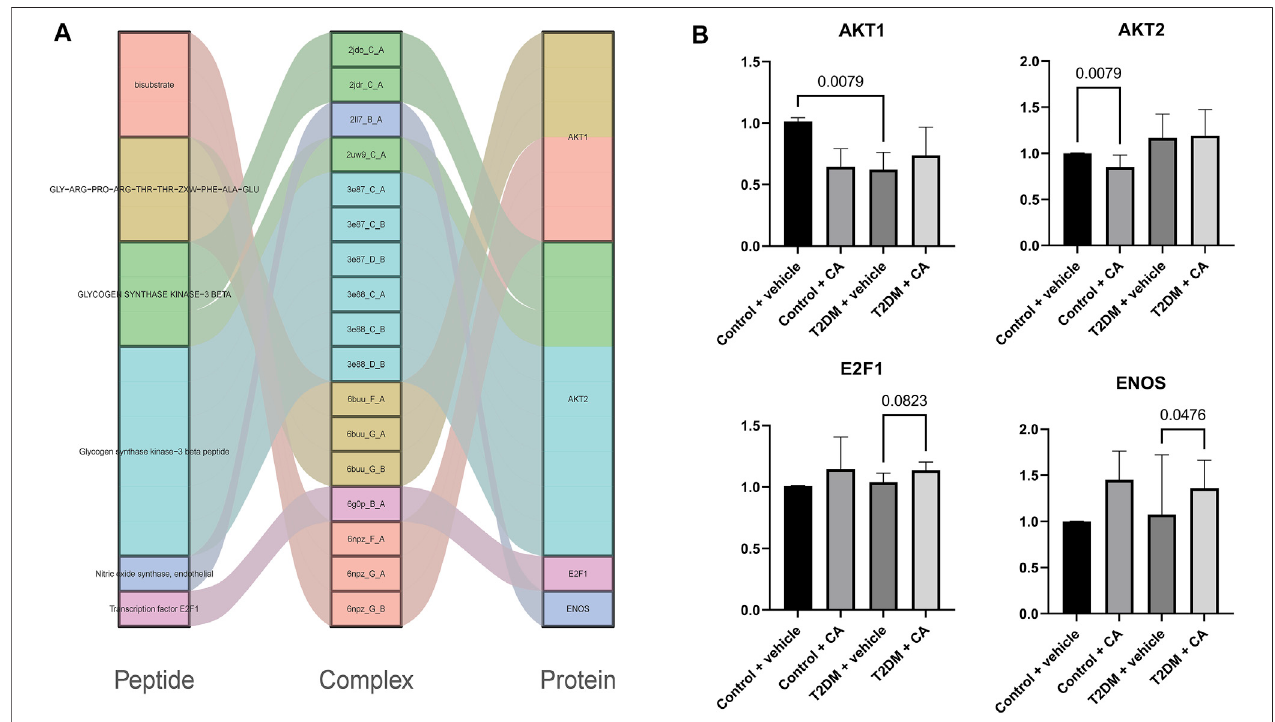
FIGURE 4 | (A) Relationships between peptides and proteins, and (B) qRT-PCR results of AKT1, AKT2, E2F1, and ENOS.